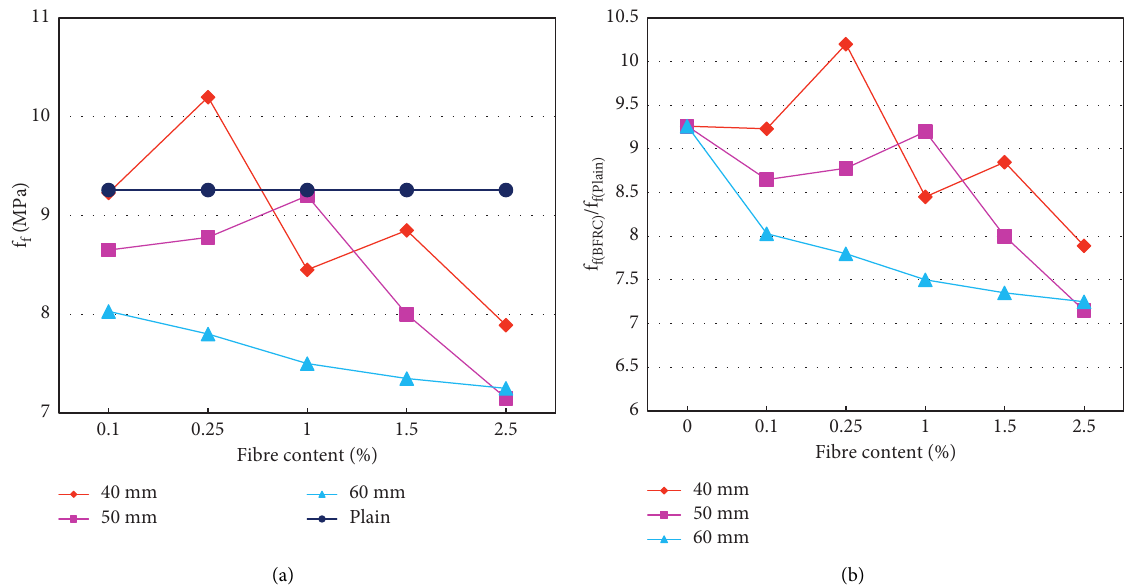
Figure 11: Effect of fibre length and fibre content on flexural strength of concrete. (a) Flexural strength. (b) Flexural strength reinforced